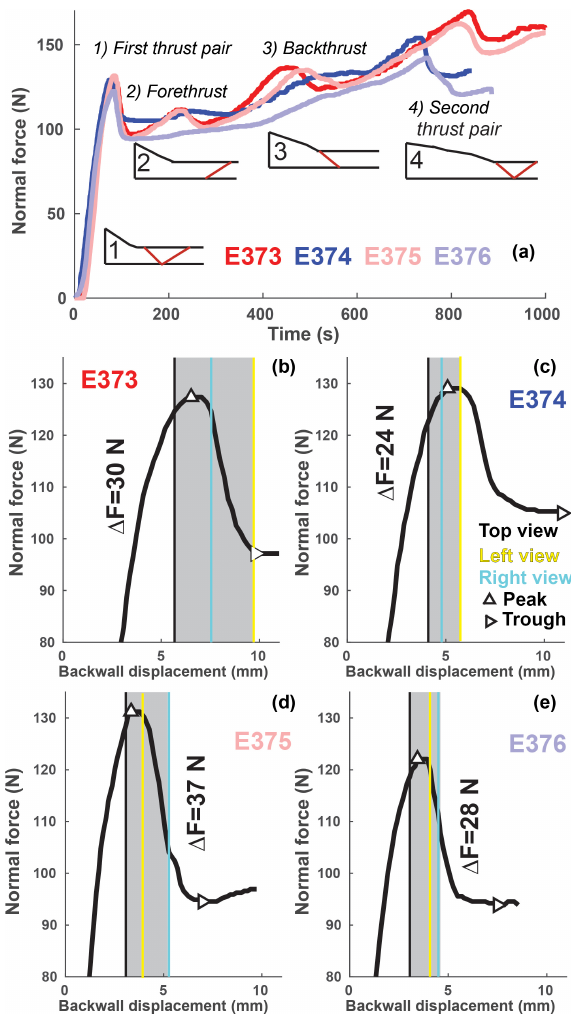
Figure 3. Backwall normal force curves with faulting events. (a) Force curves throughout complete experiments. The develop- ment of thrust pairs produced larger force drops than the develop- ment of the singular thrusts. The singular thrusts produced smaller force drops in the experiments with glass detachments than in the experiments with the sand detachments. (b–e) Force drops associ- ated with the first episode of faulting in each experiment. Vertical lines indicate when we first observed evidence of localized faulting on the top (black), left side (yellow) and right side (light blue) of the sand pack. Triangles indicate local maximum (peak, upward tri- angle) and local minimum (trough, side triangle) of first force